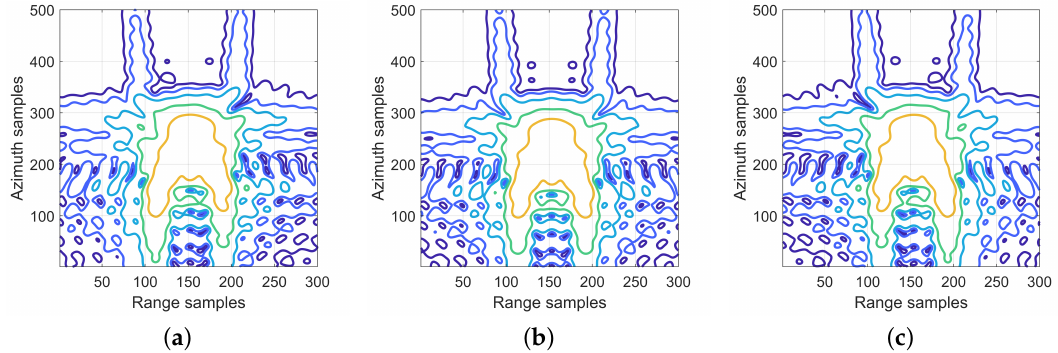
Figure 8. Imaging results of target ( a ) P 1, ( b ) P 5, and ( c ) P 9 by using start-stop model.